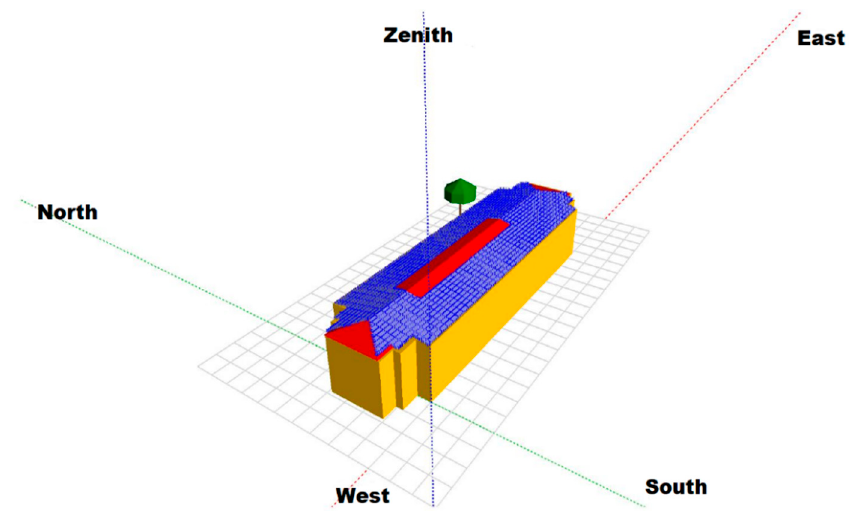
Figure 11. Photovoltaic PVSyst simulation in case study in 2019.